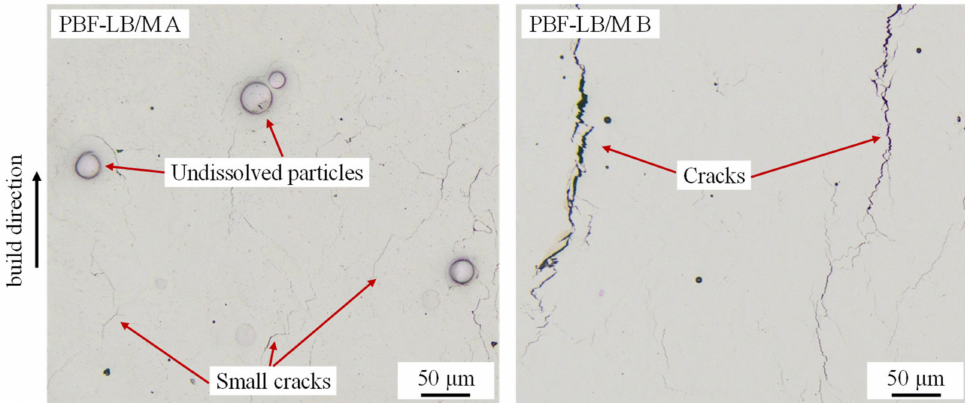
Figure 2. Microsections of WMoNbTaV-samples manufactured with parameter set PBF-LB/M A ( left ) and PBF-LB/M B ( right